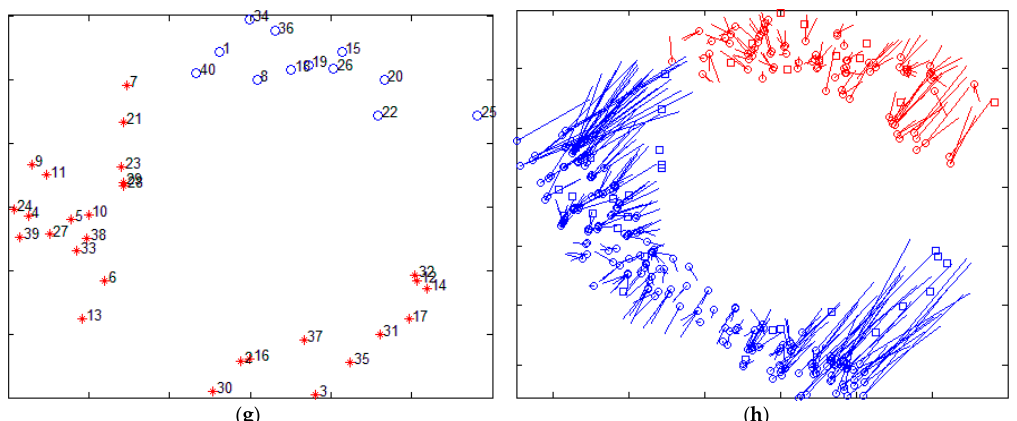
Figure 2. The localization results of SM for different regional center nodes and for different number of regions ( a ) The distribution of nodes; ( b ) The distribution of anchor nodes; ( c ) The center node is #12, area is divided into three parts; ( d ) The localization result of SM corresponds to the Figure 2c; ( e ) The center node is #17, area is divided into three parts; ( f ) The localization result of SM corresponds to the Figure 2e; ( g ) The center node is #12, area is divided into two parts; ( h ) The localization result of SM corresponds to the Figure 2g.